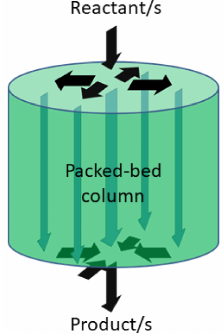
Figure 1. Idealized flow paths in a packed